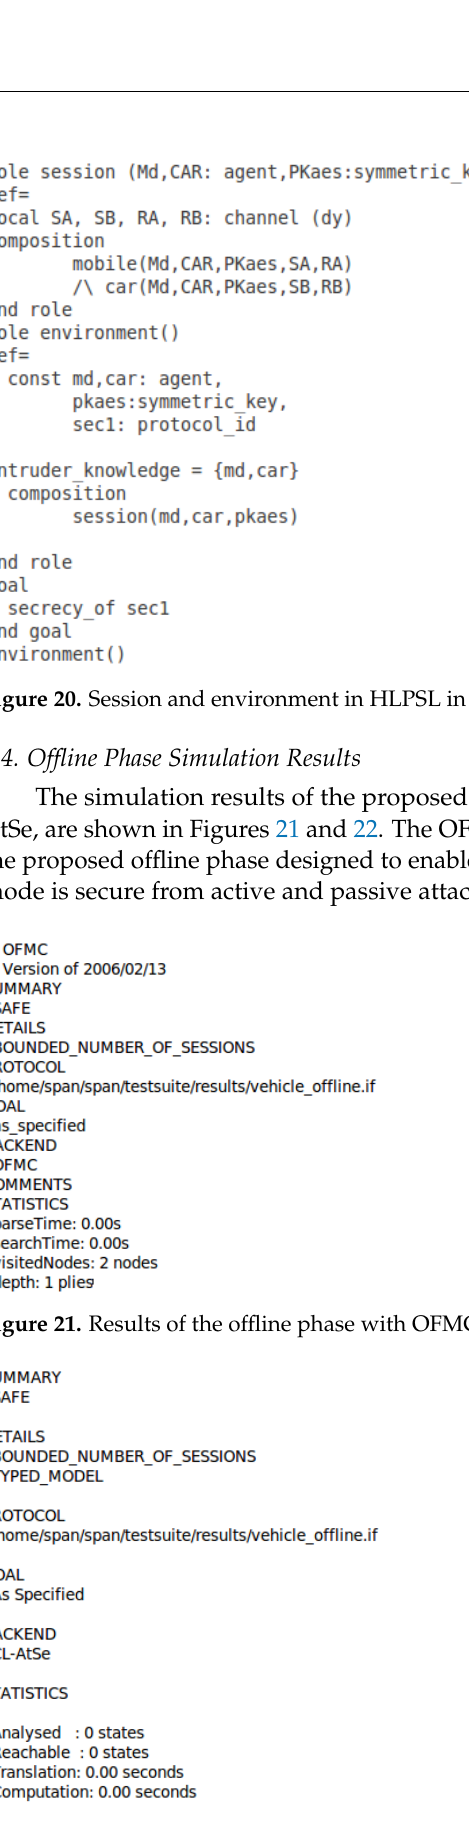
Figure 22. Results of the offline phase with CL-AtSe